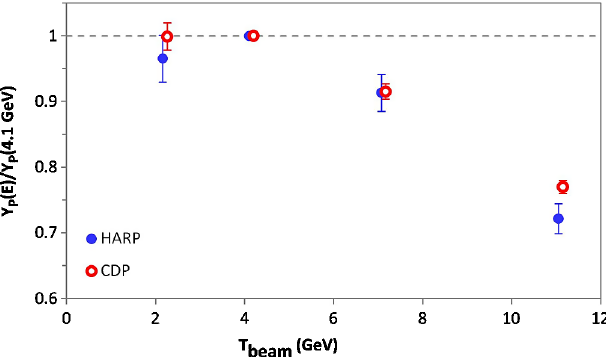
FIG. 6. Relative yield (acceptance-weighted cross section, in- tegrated over the respective phase space areas analyzed by the two HARP groups, divided by beam energy, summed over (cid:3) þ and (cid:3) (cid:1) final states, and normalized to the T beam ¼ 4 : 1 GeV value) using the HARP and HARP-CDP results. The points for HARP and CDP have been displaced, respectively, left and right by 50 MeV for clarity of presentation.